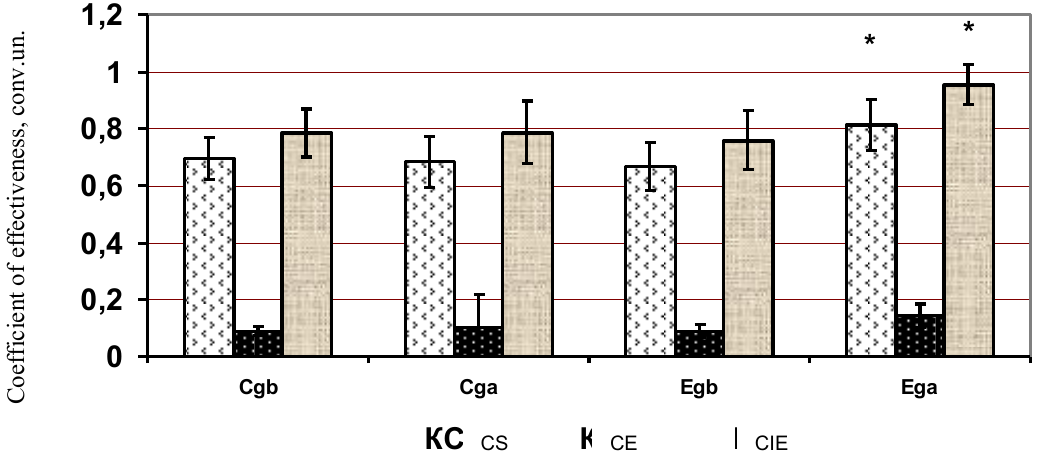
Fig.3. Integral indicators of services with rebound fulfilled by 14-15 years’ old tennis players before and after